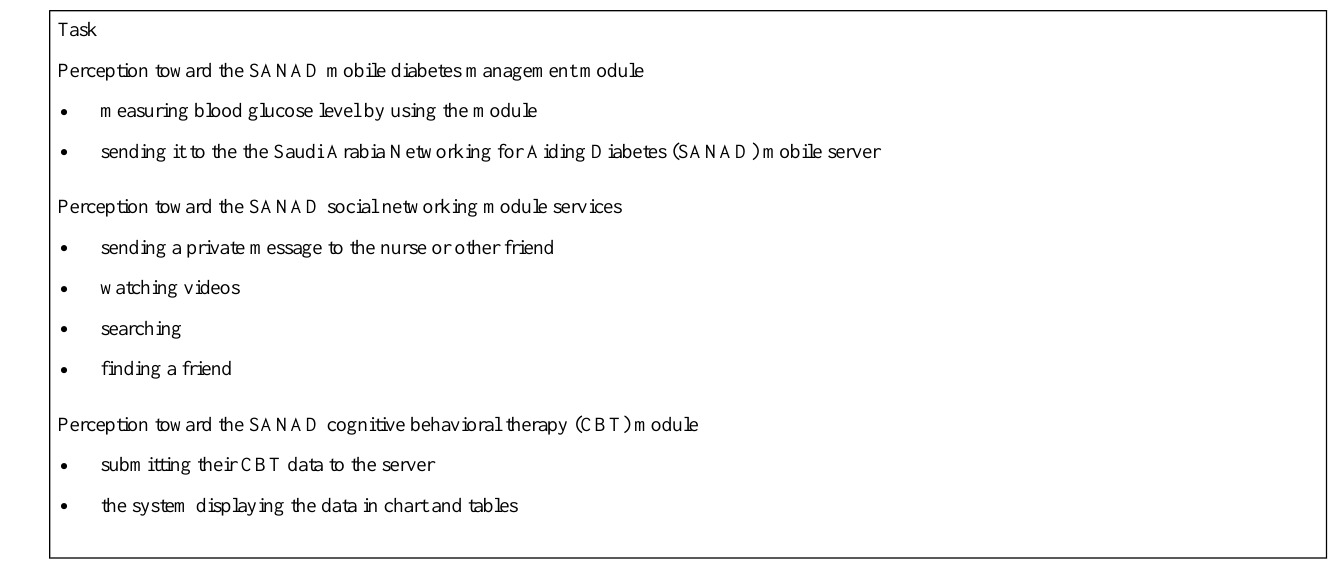
Textbox 1. Tasks designed based on the functional components of the